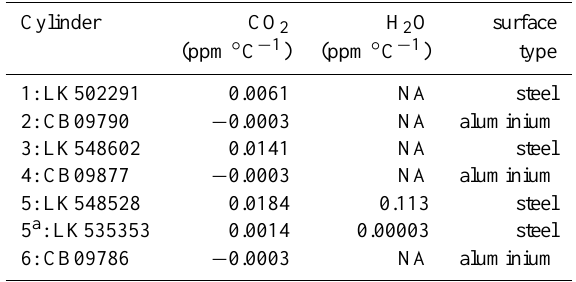
Table 2. Temperature dependencies of gas adsorption on steel and aluminium surfaces for CO 2 and H 2 O applying a temperature range from − 10 to + 50 ◦ C. NA when r 2 <0.02. Temperature dependen- cies for CO and CH 4 could not be detected within experimental uncertainties.